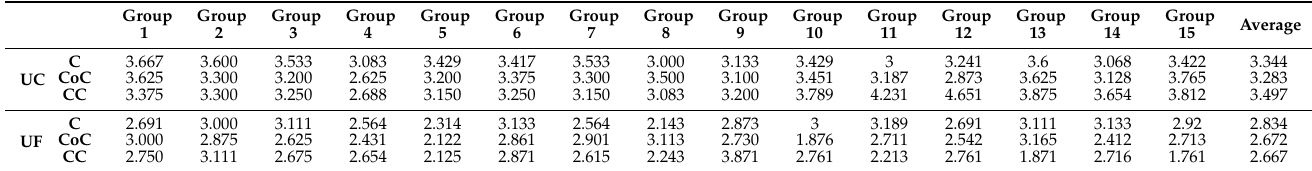
Table 13. Tasks of the shared understanding stage for UC and UF.